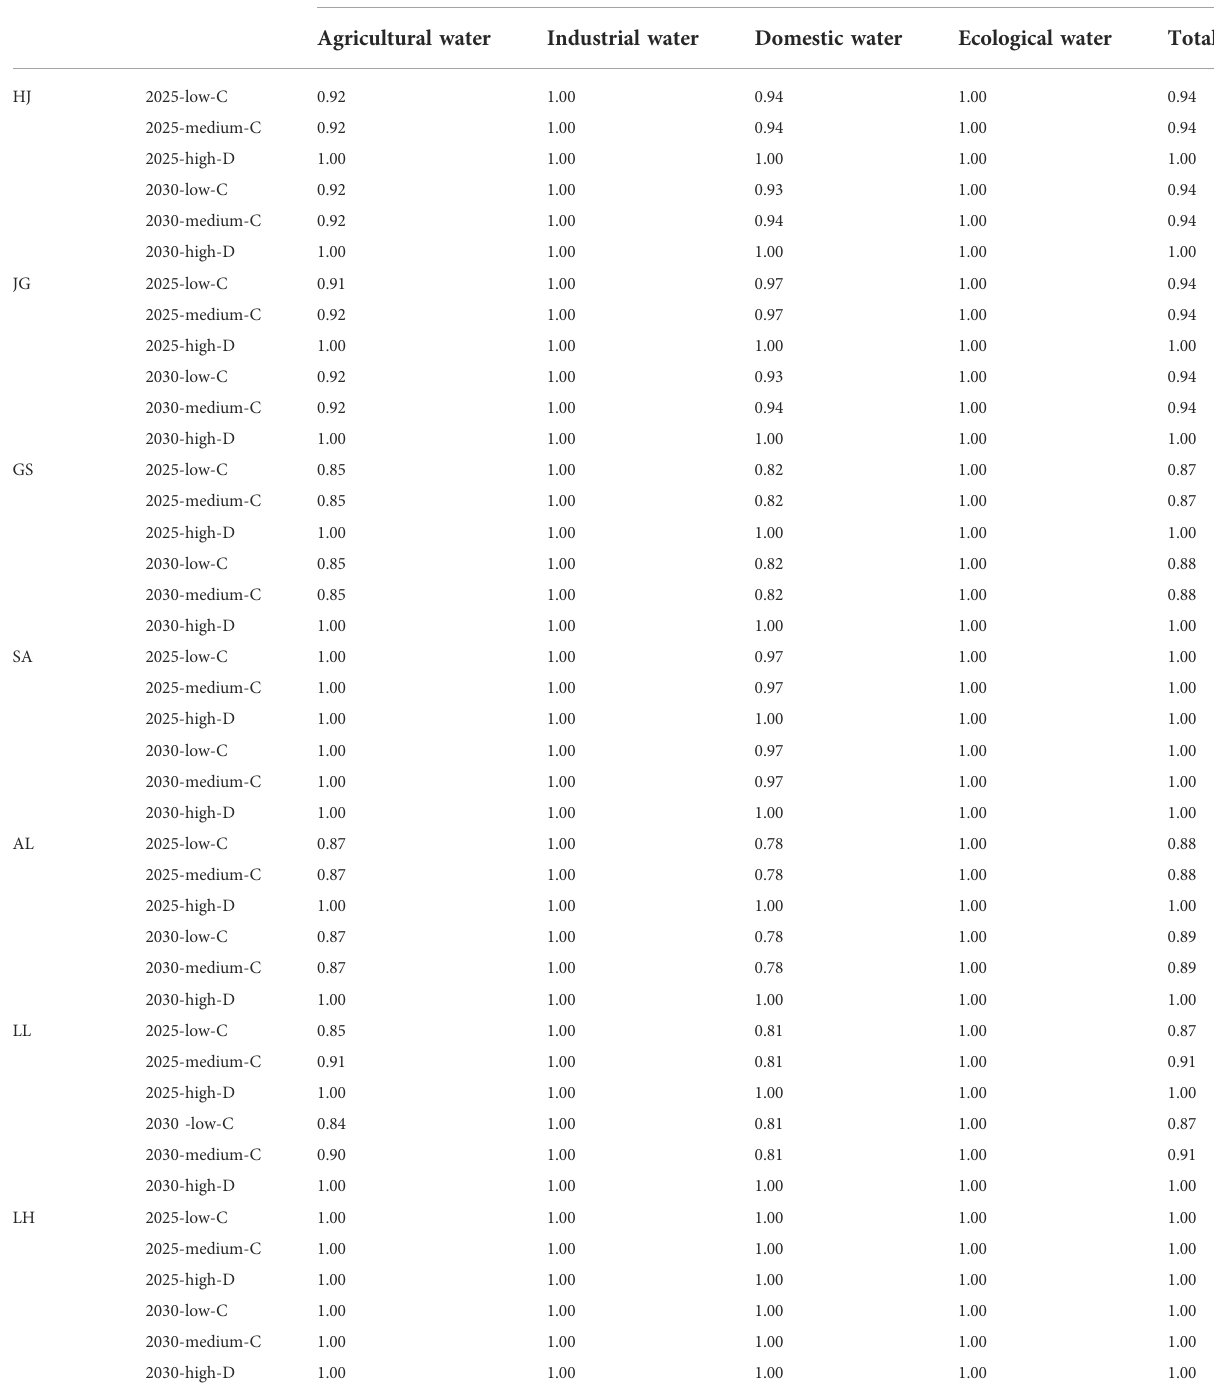
TABLE 7 Water supply rate of six suitable scenarios in seven